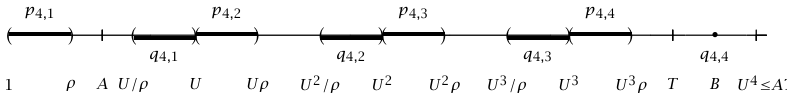
Figure 3.2 . The distributions F and G of Theorem 3.3, with n =